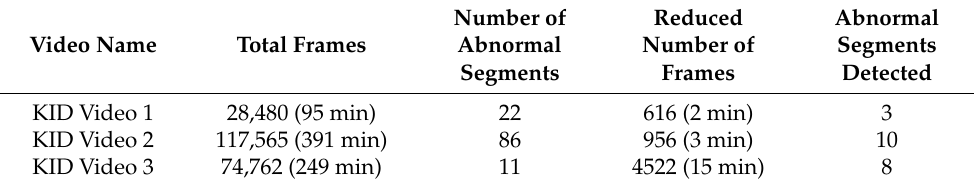
Table 1. Single Network Trained on Non-Augmented Videos.